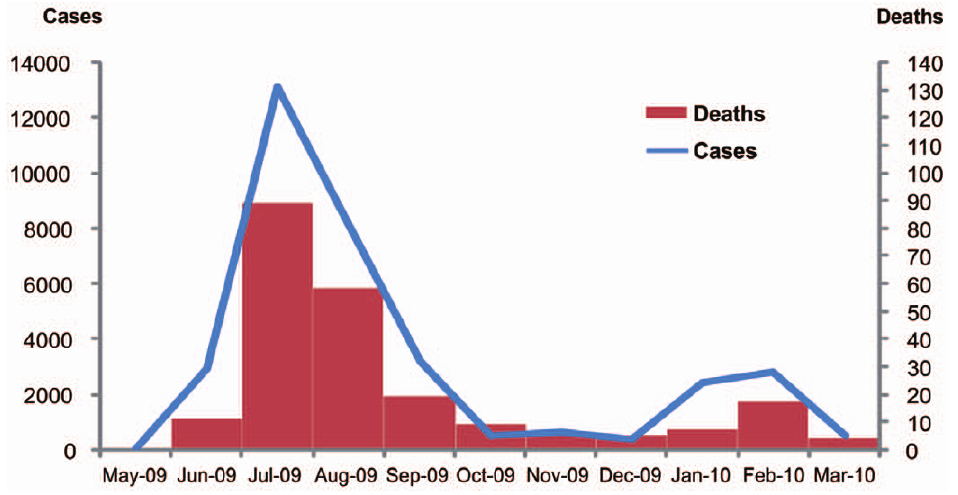
Figure 1. Laboratory-confirmed influenza A (H1N1)pdm09 cases and deaths. Detailed legend: Laboratory-confirmed influenza A (H1N1)pdm09 cases and deaths reported to Bureau of Epidemiology, Ministry of Public Health Thailand from May 2009-March 2010. Bars represent number of deaths. Line represents number of cases.